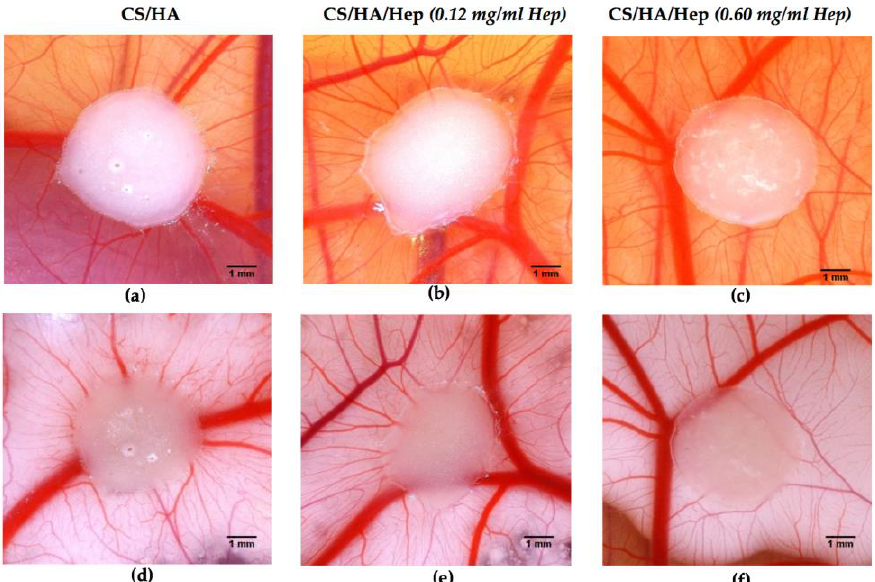
Figure 11. Comparative chorioallantoic membrane (CAM) images taken at day-14 of embryo incubation to evaluate angiogenic response of hydrogel samples: ( a ) CII: CS.0.1HA; ( b ) SI: CS.0.1HA.0.005Hep (0.12 mg / mL Hep); ( c ) SIII: CS.0.1HA.0.025Hep (0.60 mg / mL Hep), and images after white cream injection underneath CAM to make blood for contrast: ( d ) CII; ( e ) SI; ( f ) SIII.